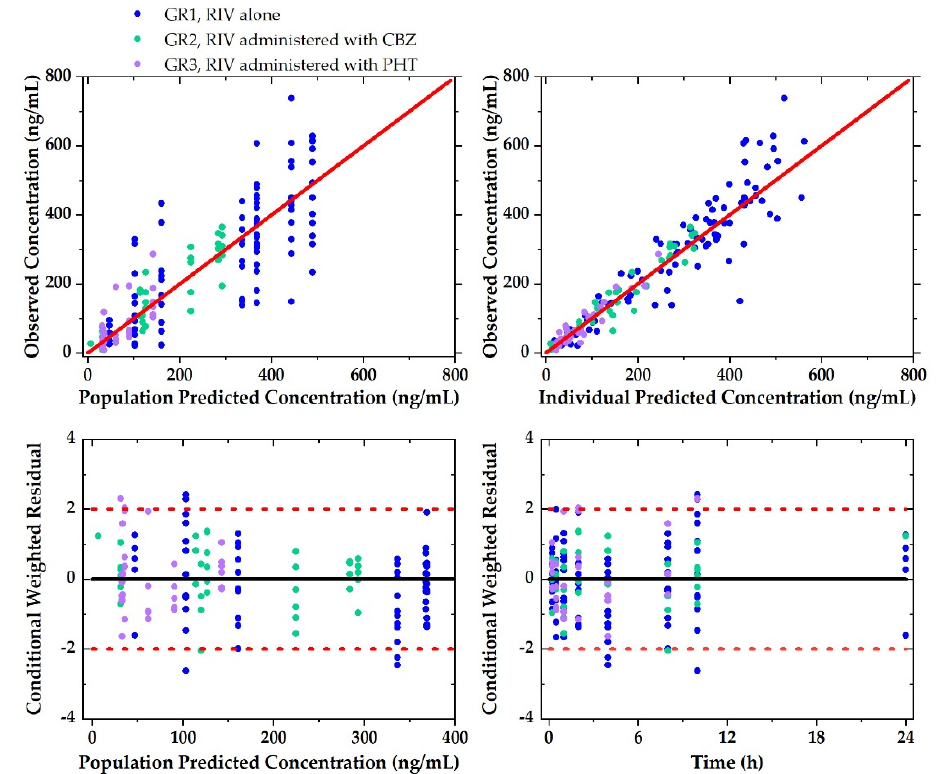
Figure 4. Goodness-of-fit plots of the final model on PKs of RIV.